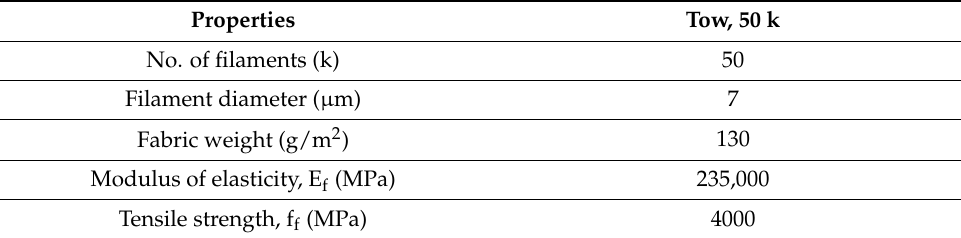
Figure 1. Typical uni-direction carbon textile used as reinforcement. Table 1. Engineering properties of carbon textile reinforcements.